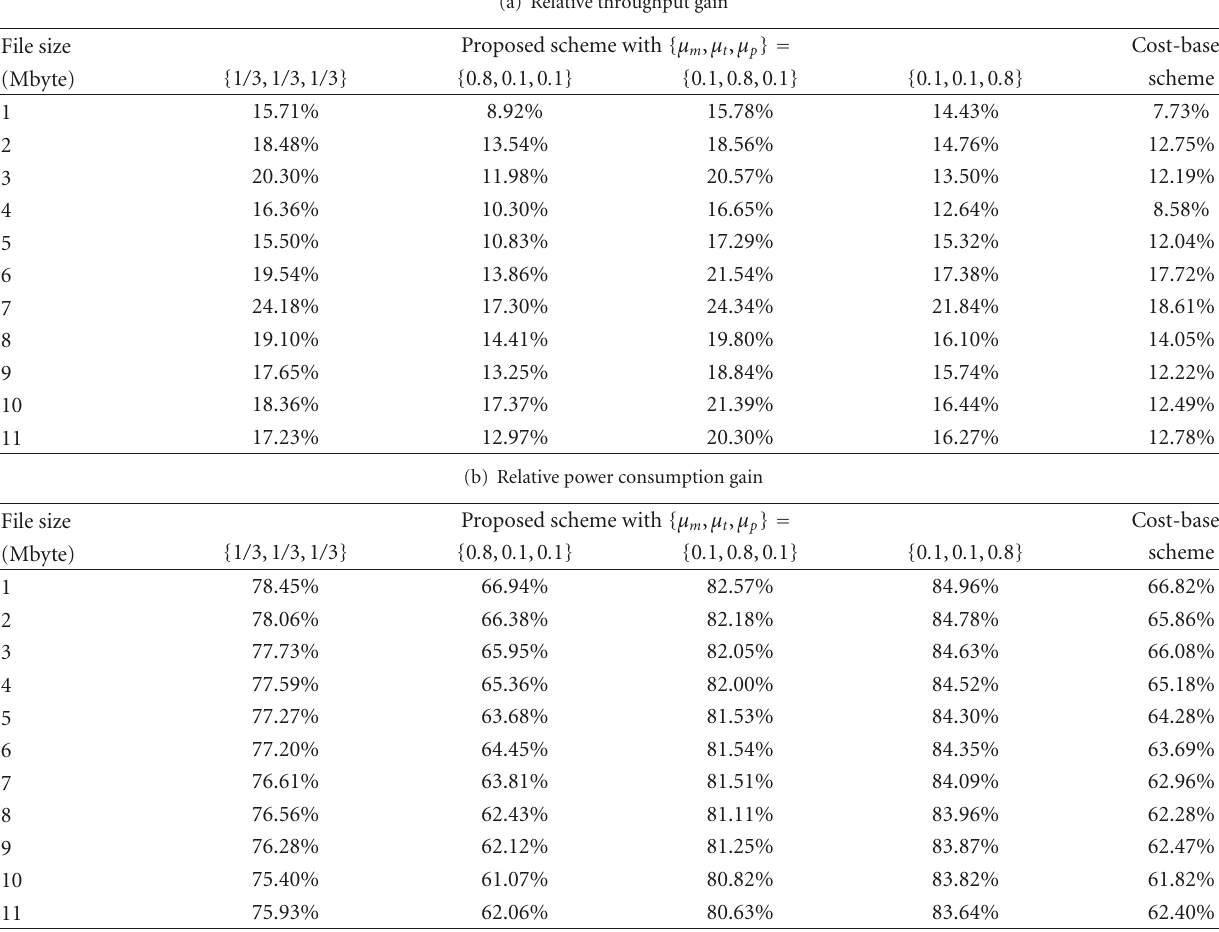
Table 4: Relative performance gain of the proposed and the cost-based schemes over WFS when the TCP tra ffi c ( ρ = 1) is generated.